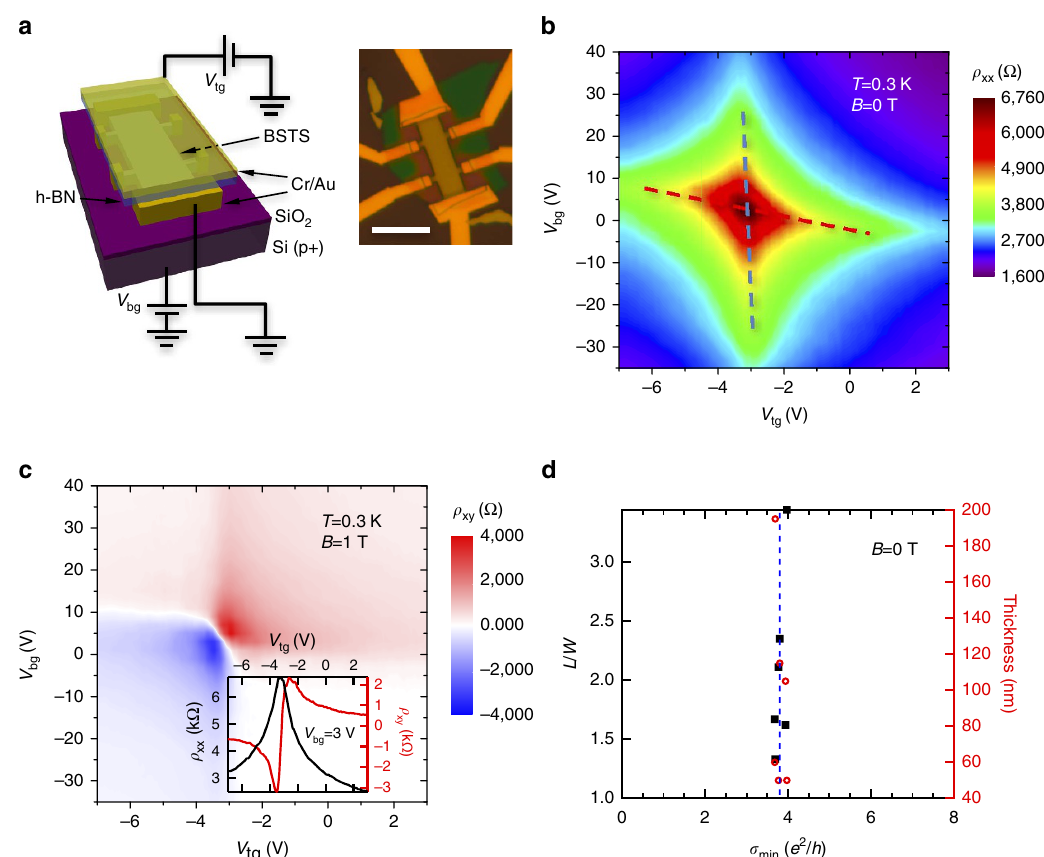
Figure 1 | Device configuration and dual-gated field effect at zero and low magnetic field. ( a ) Device schematic. Inset is an optical microscope image of a typical dual-gated BSTS device before depositing the top-gate metal; Scale bar, 10 m m. ( b , c ) show 2D maps of r xx at B ¼ 0Tand r xy at B ¼ 1Tas functions of V tg and V bg on sample A. The blue (red) dashed lines in b are guides to the eye for the top (bottom) surface DP. The 2D map is generated by data measured from V tg -sweeps at a series of V bg values, with one example at V bg ¼ 3V shown in the inset of c . ( d ) Zero-magnetic-field minimum conductivity s min (bottom axis) measured in six dual-gated samples at low temperature ( o 2K) plotted as a function of the sample thickness (data in circles) and 2D aspect ratio ( L / W , data in squares). The vertical dashed line indicates 3.8 e 2 / h